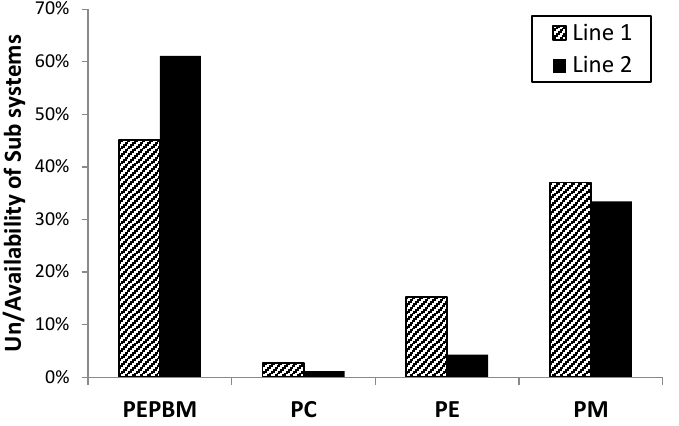
Table 8. Comparison of MTBF and MTTR of subsystems in Lines 1 and 2.